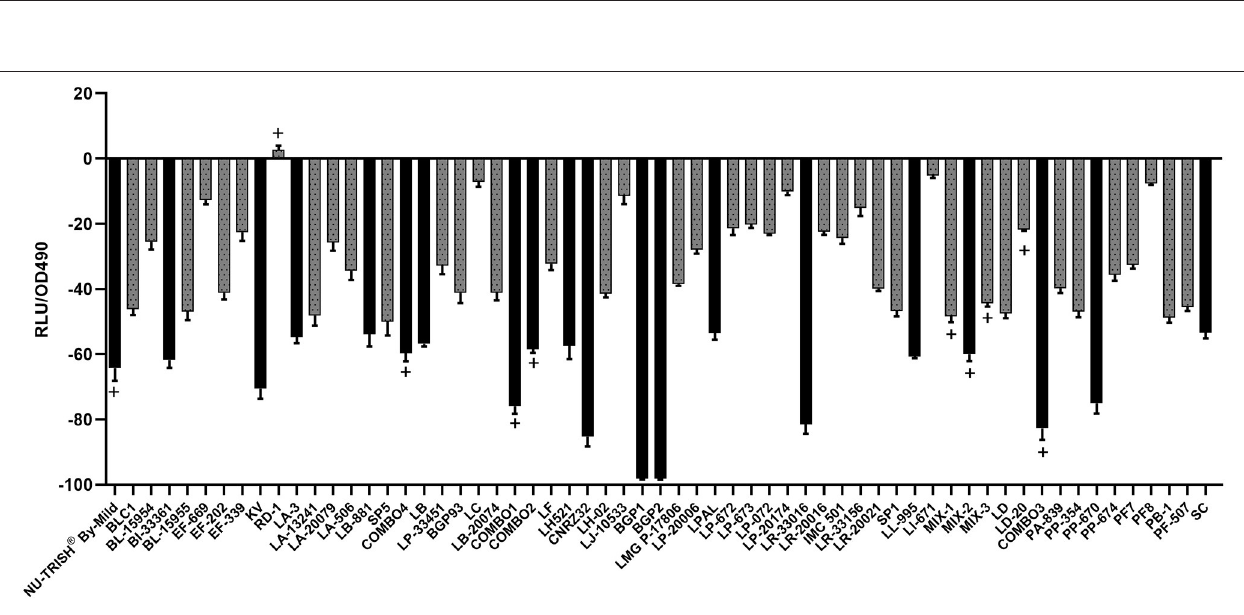
COMBO4 ( L. delbrueckii subsp . bulgaricus and S. thermophilus ), as well as L. helveticus CNRZ32 significantly downregulated hilA expression with 4.6 to 43 fold, ssrB expression with 8.7 to